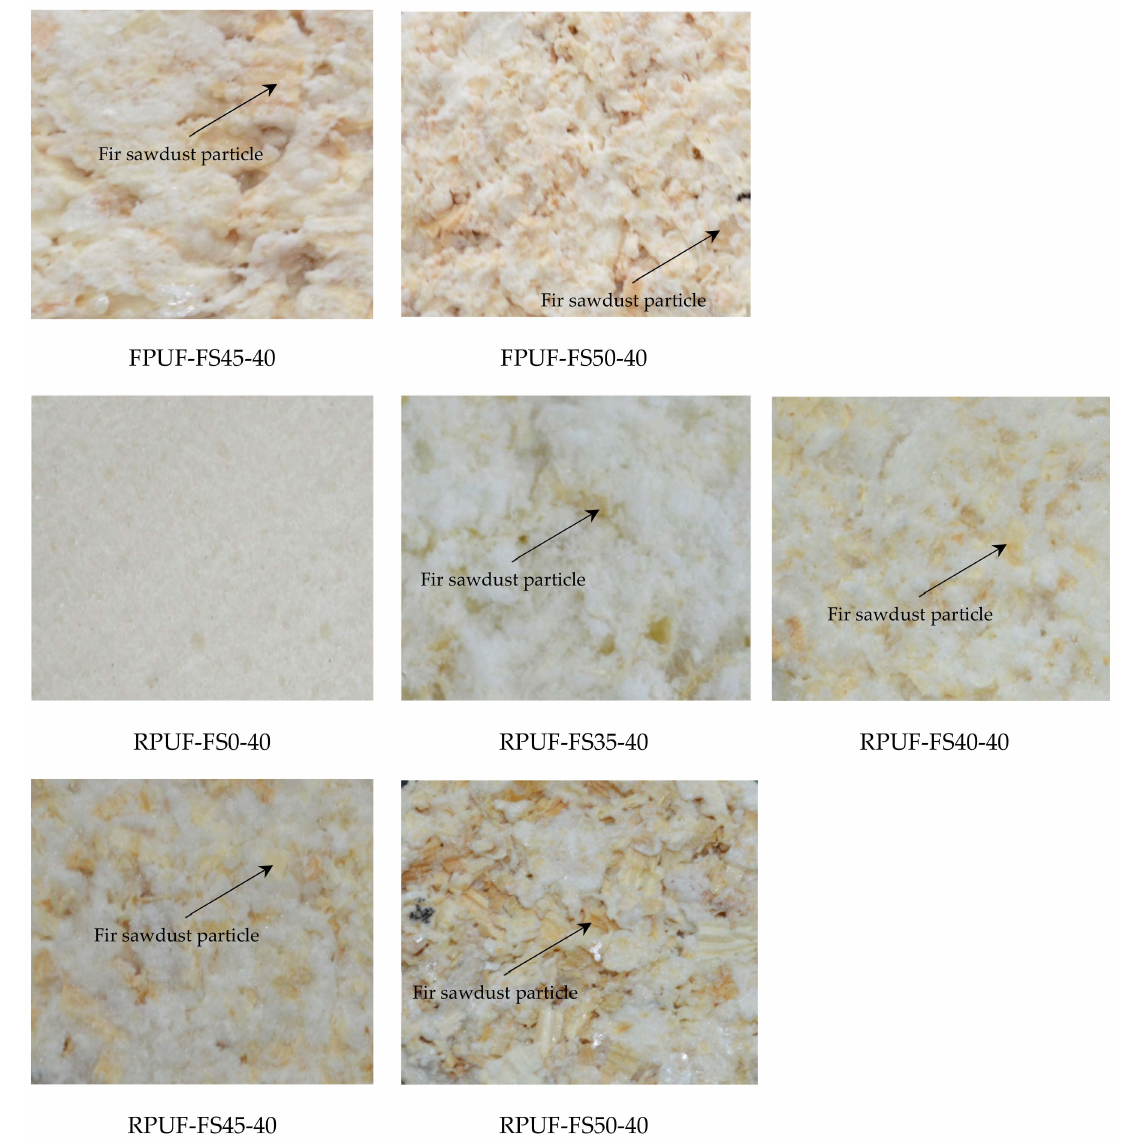
Figure 3. Surface images of the obtained